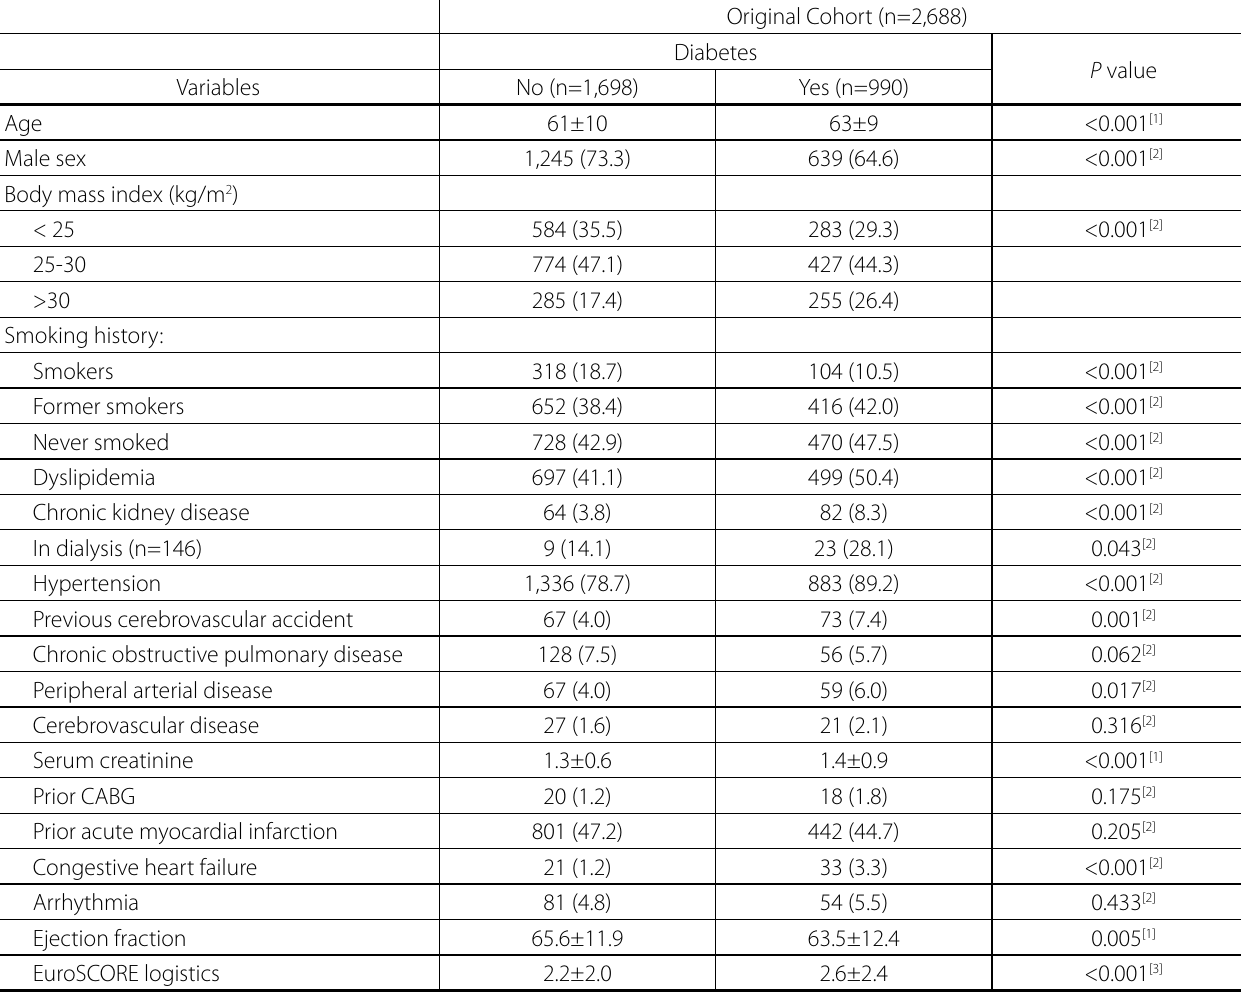
Table 1. Descriptive values [average ± standard deviation or n (%)] of preoperative variables according to the study